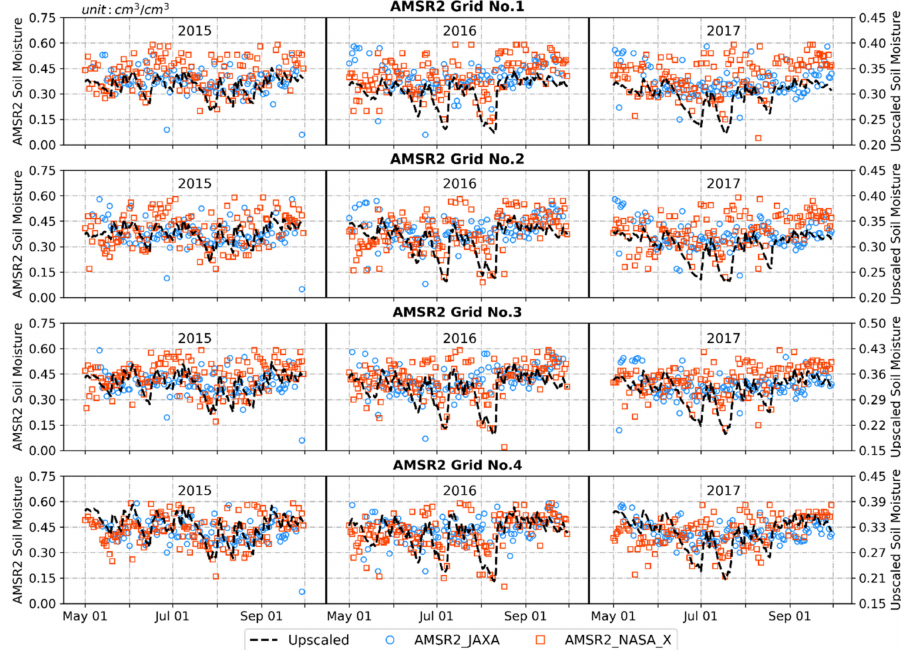
Figure 11. Temporal comparisons between the upscaled SM and ARMS2 products with different retrieval algorithms at the 0.25 ◦ scale.